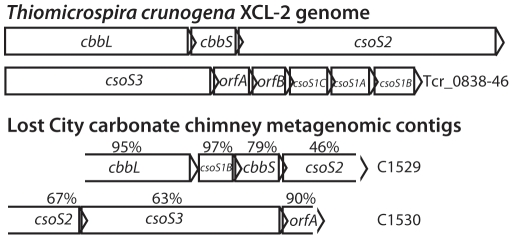
Most of the genes in the carboxysome operon of Thiomicrospira crunogena are present in Lost City metagenomic sequences.Amino acid percent identities between putative homologs are shown. The Lost City sequences are incomplete; it is expected that further sequencing and assembly will yield a complete carboxysome operon. cbbL and cbbS encode the large and small subunits of RubisCO. csoS3 encodes carbonic anhydrase. All other genes are expected to encode structural proteins forming the carboxysome shell. Accession numbers for contigs C1529 and C1530 are ACQI01001529 and ACQI01001530.